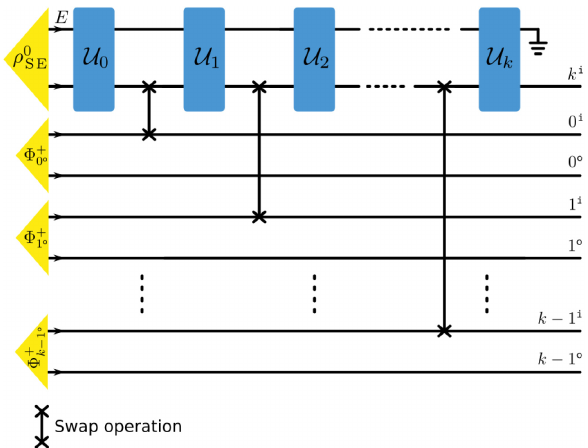
FIG. 17. Choi state of a process tensor. At each time, half of an unnormalized maximally entangled state is fed into the pro- cess. For better bookkeeping, all spaces are labeled by their respective time. The resulting many-body state ϒ T all spatiotemporal correlations of the corresponding process as spatial